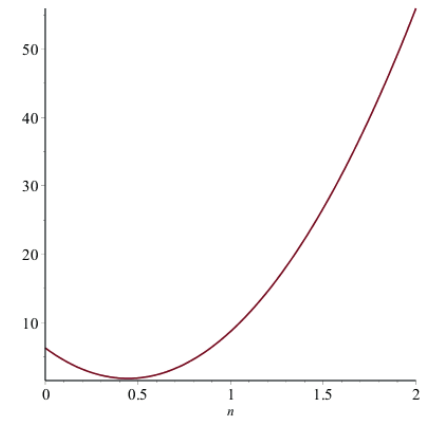
Figure 10: Plot of SSD ( D